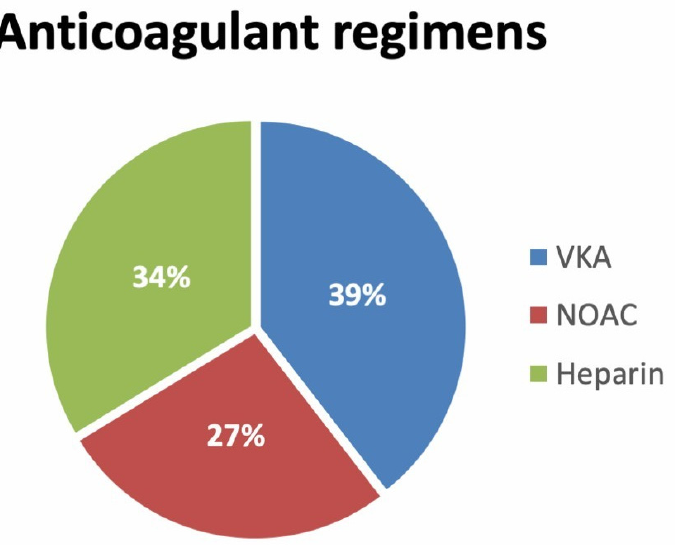
Figure 3. Anticoagulant regimens. List of abbreviations: VKA, vitamin K antagonists; NOAC, non-vitamin K antagonist oral anticoagulants.